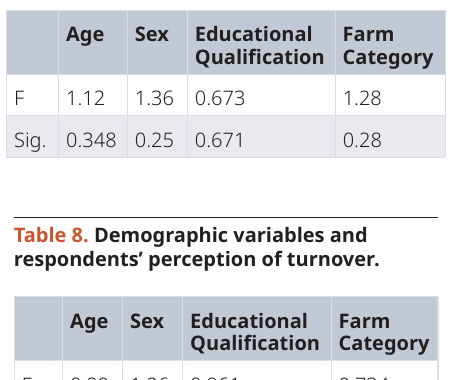
Table 7. Demographic variables and respondents’ perception of cost reduction.